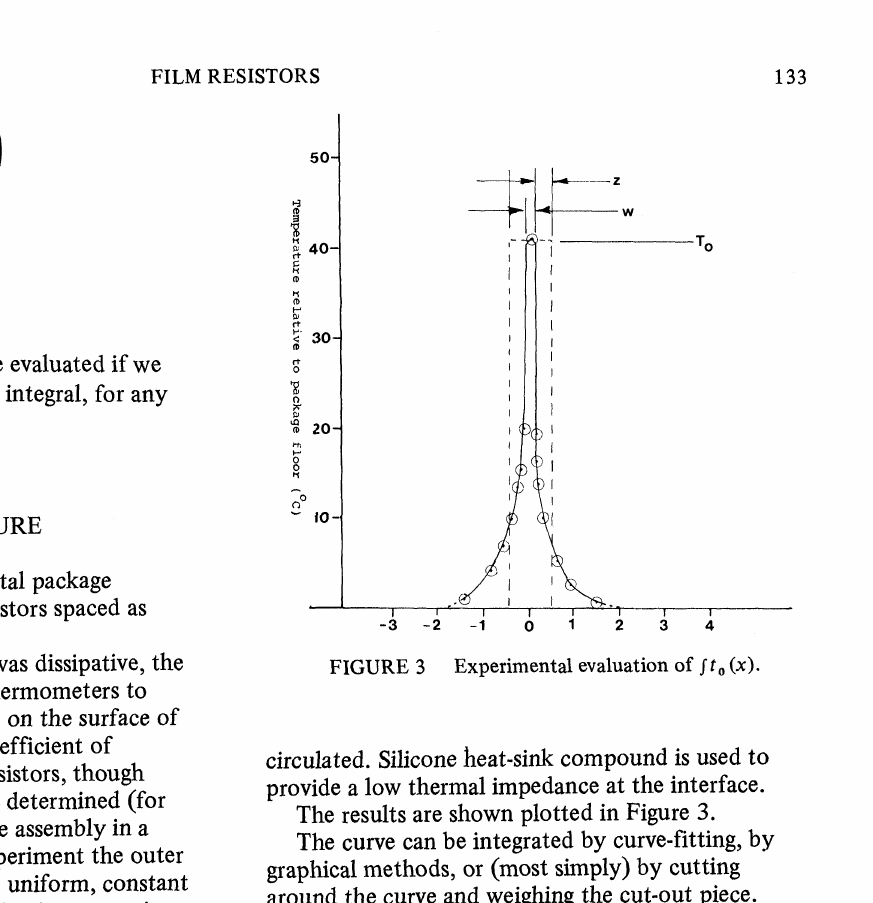
Disposition of resistors for the determination of surface temperature profile adjacent to single, "long", dissipative resistor Resistor No.